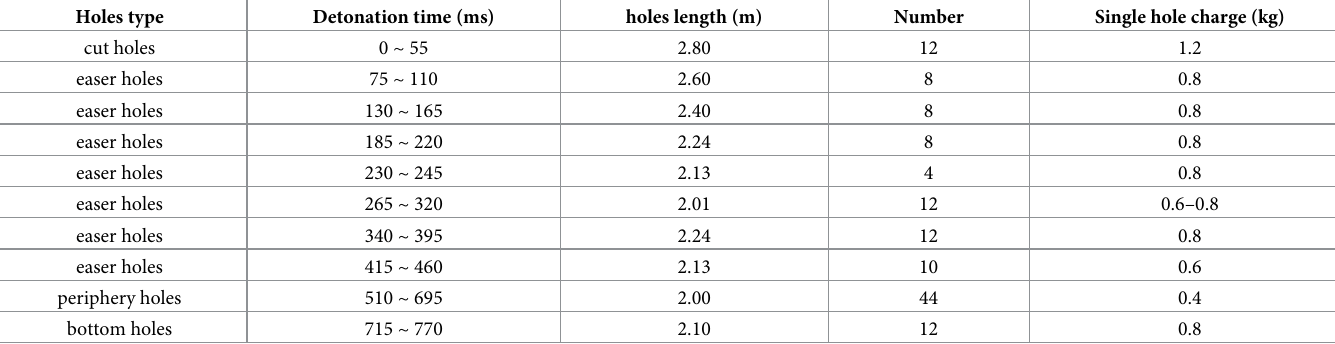
Table 7. Blasting parameters using digital